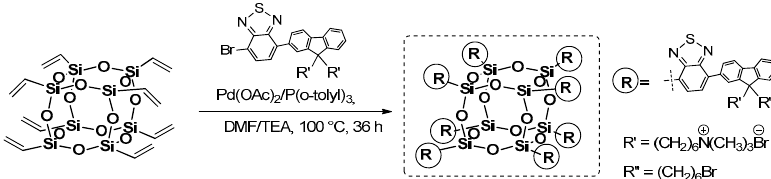
Figure 9. Efficient Heck coupling for the formation of octa-substituted T 8 with conjugated fluorene and benzothiazole units.